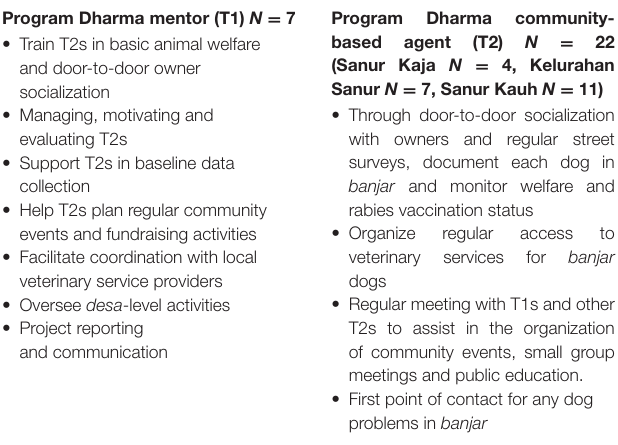
TABLE 1 | Responsibilities of the two key roles in Program Dharma; the mentor (T1) and the community-based agent (T2). Program Dharma mentor (T1) N =